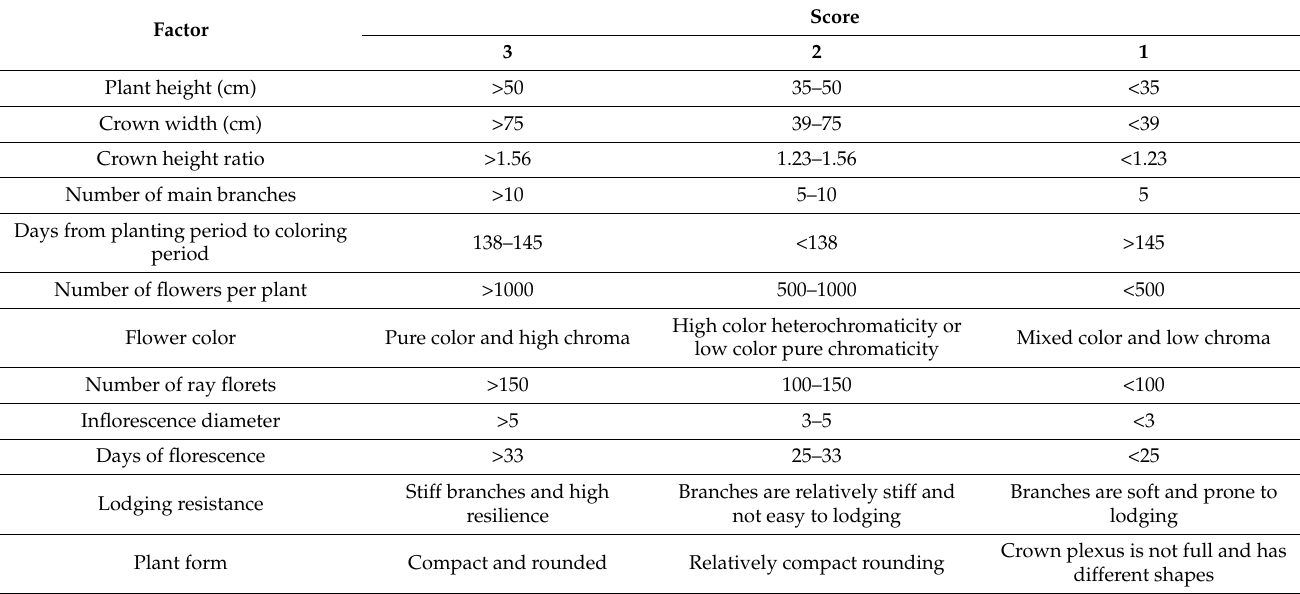
Table 3. Appraisal criterion of all